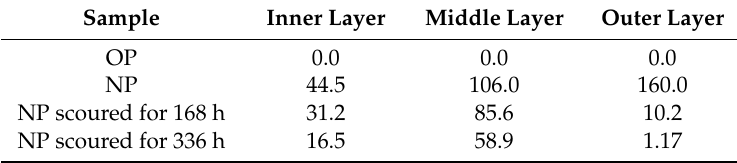
Figure 3. Schematic diagrams positions and different layers in impregnated pressboards. Table 1. Content of titanium element in different layers in impregnated pressboards (Unit: ppm).